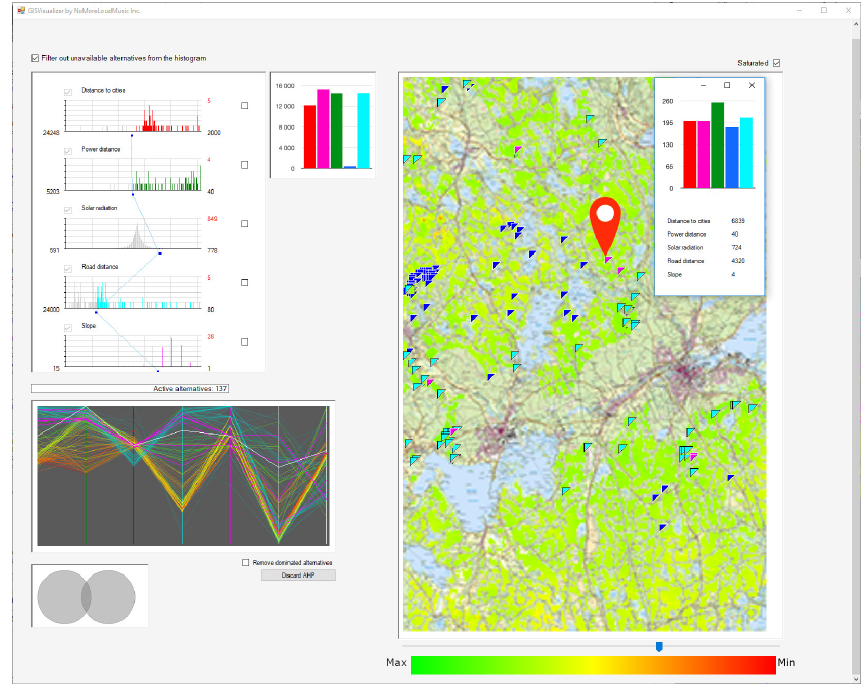
Figure 12. The full view of the GISAnalyzer main window after applying even swaps to obtain the most preferred